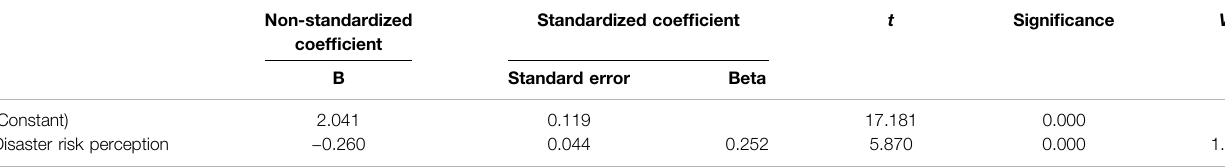
TABLE 6 | Analysis of the impact of disaster risk perception on tourists ’ behavioral